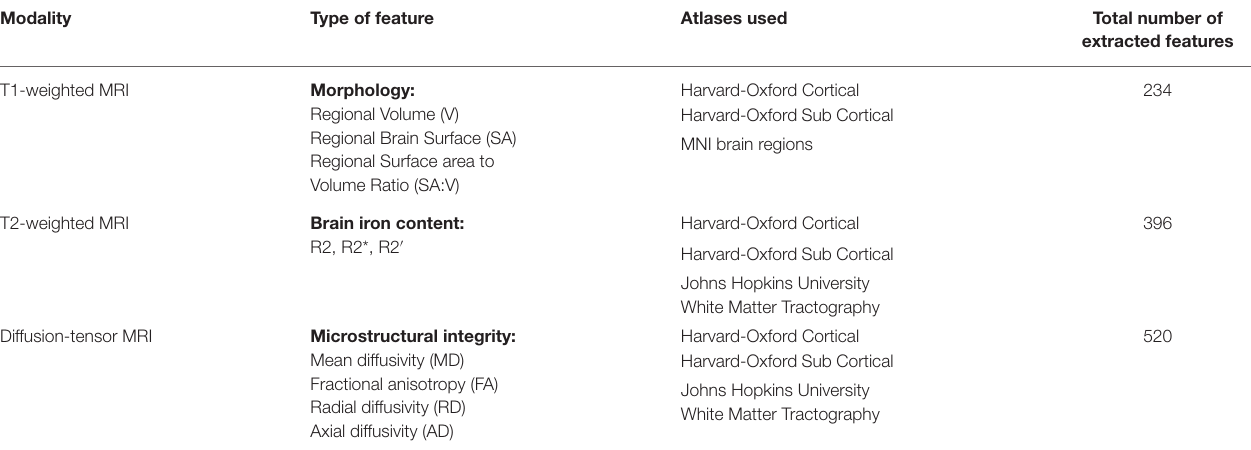
TABLE 2 | Overview of atlases and number of features extracted for regional analysis of morphology, brain iron accumulation/deposition, and microstructural